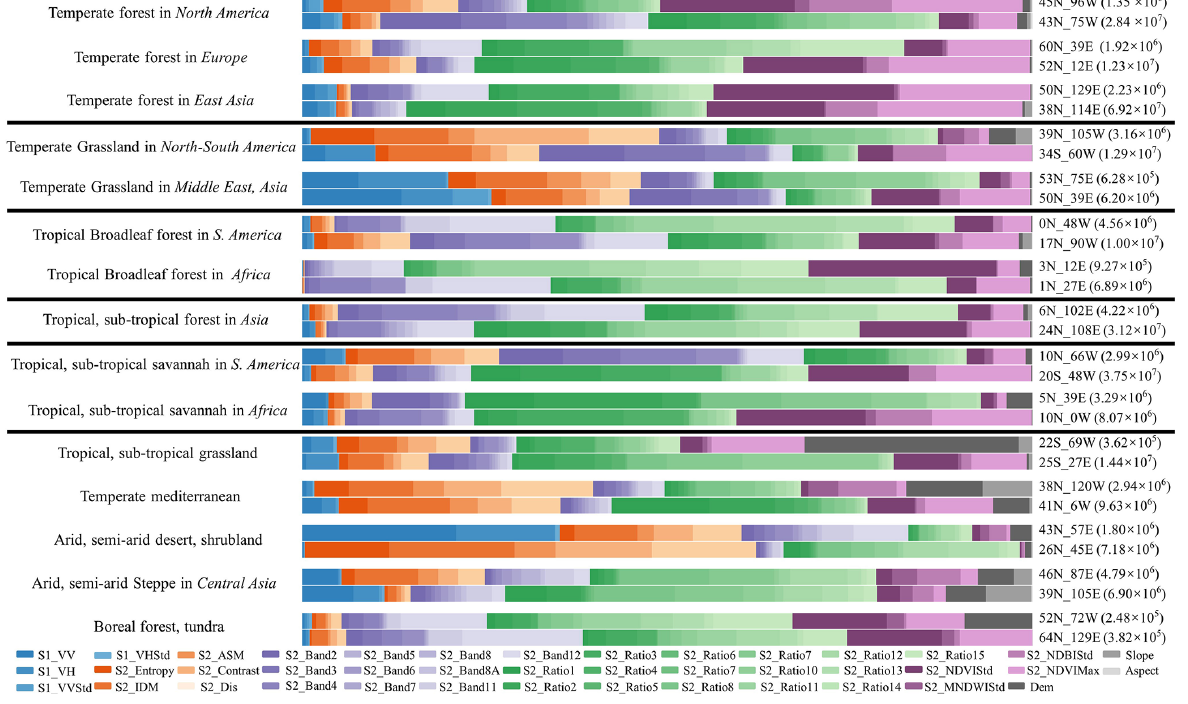
Figure 13. Relative importance of the multi-source features in 30 randomly selected grids located in different urban ecoregions. The labels on the right denote the grid ID and total population. Dis, IDM, and ASM represents the dissimilarity, angular second moment, and inverse difference moment,